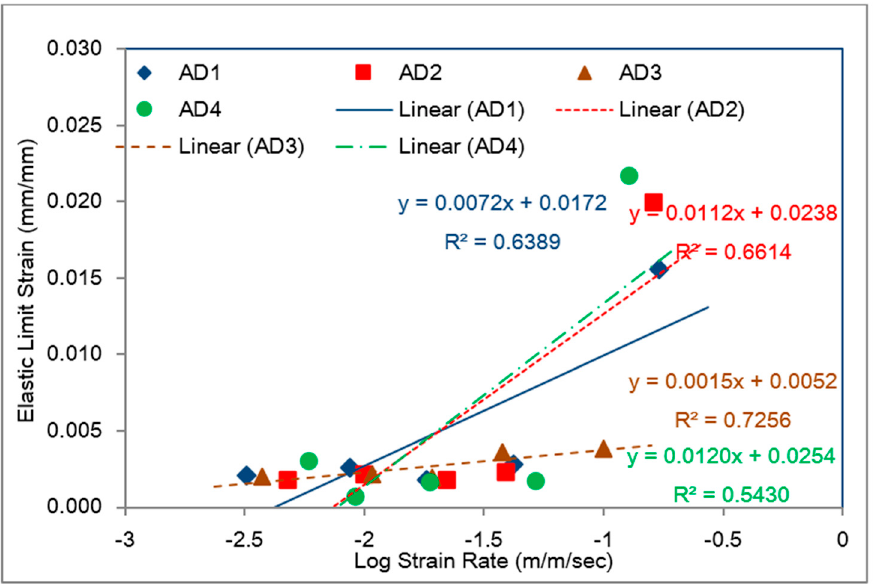
Figure 20. Variation of the elastic limit strain, ε 2 , fitted based on the bilinear-viscoelastic model as a function of strain rate during tensile tests.